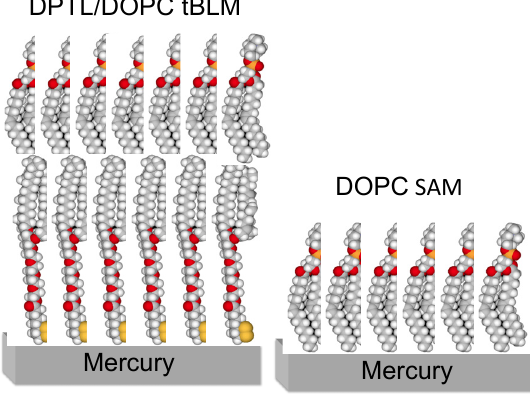
Figure 1. Schematic picture of a phosphatidylcholine (DOPC) self-assembled monolayer ( right ) and of a DPTL/DOPC tethered bilayer lipid membrane ( left ). Hydrogen atoms are marked in white, carbon atoms in gray, oxygen atoms in red, phosphorus atoms in orange and sulfur atoms in